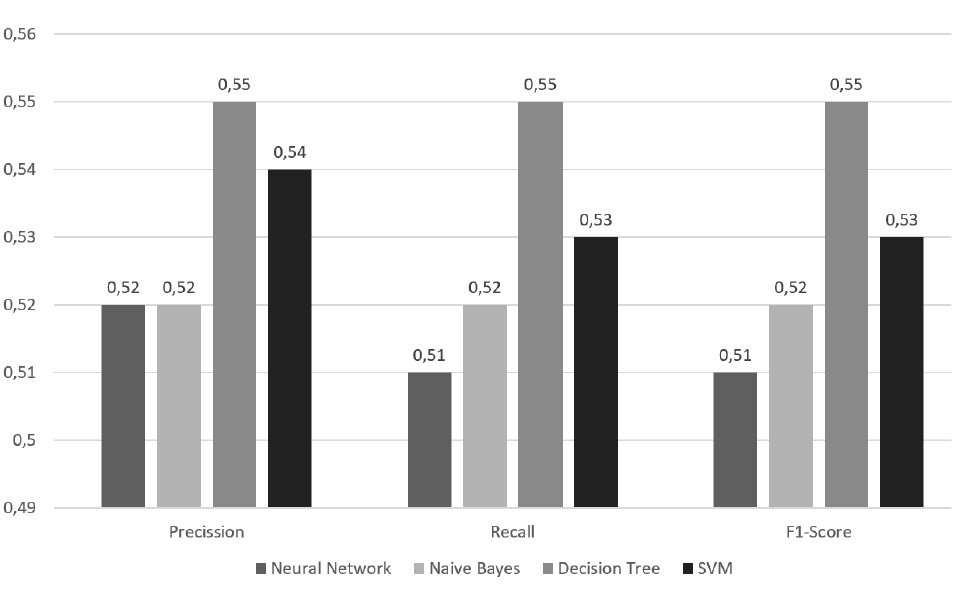
Fig. 3. Classification result of each